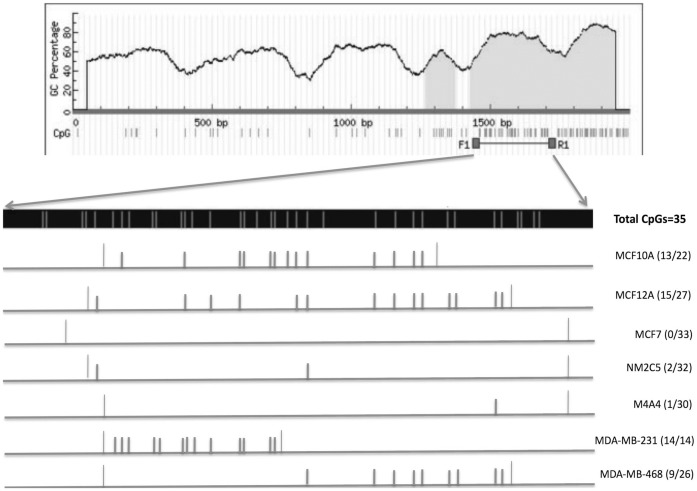
Promoter Methylation Status in the MCF10A cell lines.Candidate CpG islands were identified in the HtrA1 promoter sequence, within the upstream region from bp −561 to −266. DNA was extracted from the various cell lines and analyzed via bisulfite sequencing. The topmost Panel shows this region of interest, which is expanded in the dark strip from F1–R1, with CpG sites indicated by vertical lines (the total of 35 CpGs are marked). Unmethylated CpGs identified by bisulfite sequencing are depicted in the lower panels for the various cell lines, as indicated on the right.